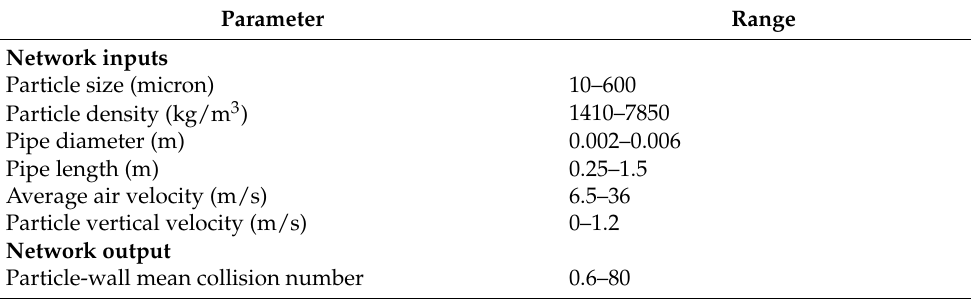
Table 1. Table 1. Network inputs and output.